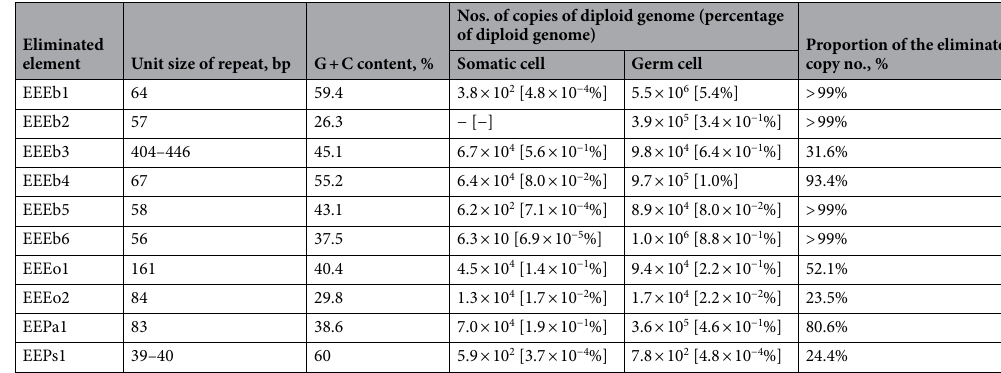
Table 2. Summary of the eliminated elements in E.